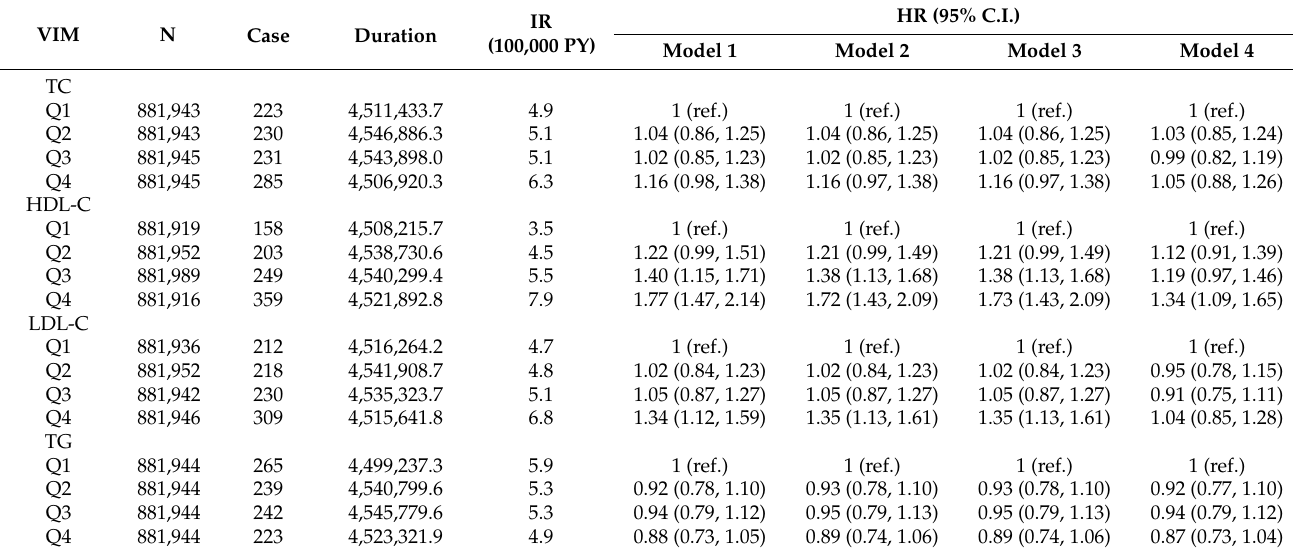
Table 3. Risk of Multiple Myeloma by quartiles of lipid variability